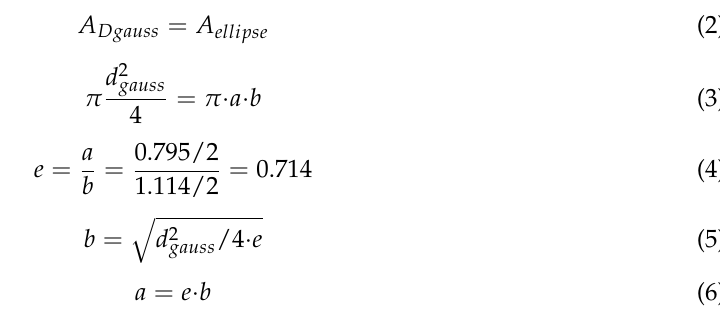
Figure 17. Increase of the real strut diameter fabricated by SLM described in the study